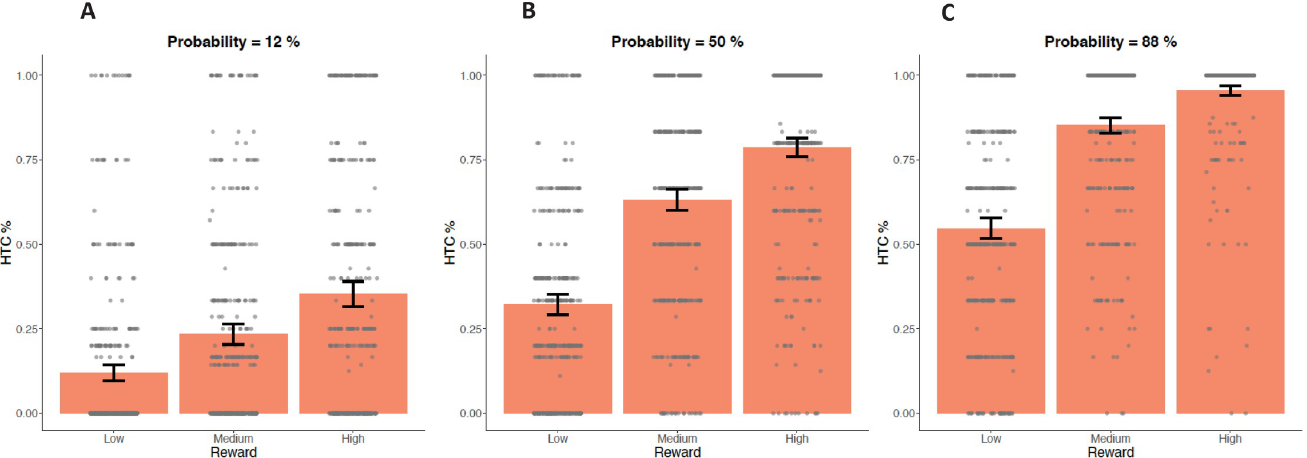
Fig 5. Percentage of hard task choices (HTC) within the original EEfRT in Study 2. Comparison of trials with low probability of reward attainment (left; A), medium probability of reward attainment (middle; B) and high probability of reward attainment (right; C) within the original EEfRT. For each probability category, all three reward magnitude categories (low / medium / high) are displayed. Data points are added as dots for individual scores. Error bars depict a 95% confidence interval (CI) of the mean.